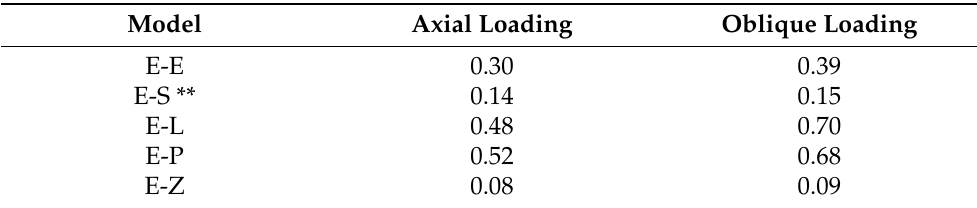
Table 4. The Mohr–Coulomb ratio in endocrowns from all materials when axial and oblique loadings were applied